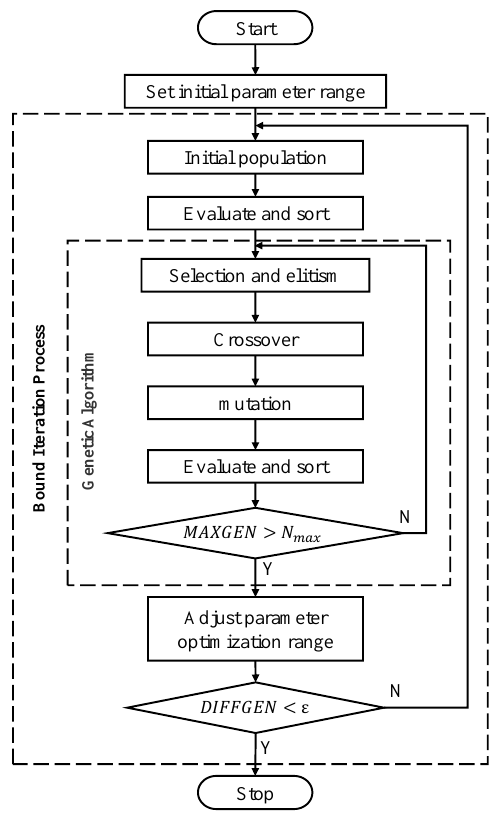
Figure 9. Flow chart of the archive-based micro genetic algorithm (AMGA) progress.